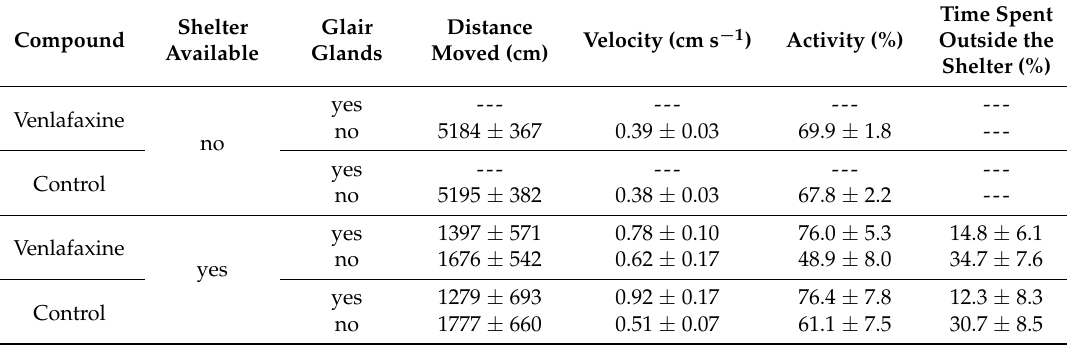
Table 4. The values of the distance moved, velocity, activity, and time spent outside the shelter in crayfish exposed to venlafaxine and in control crayfish in accordance with the presence of glair glands, in set-ups with and without available shelter. Data are shown as mean ± standard